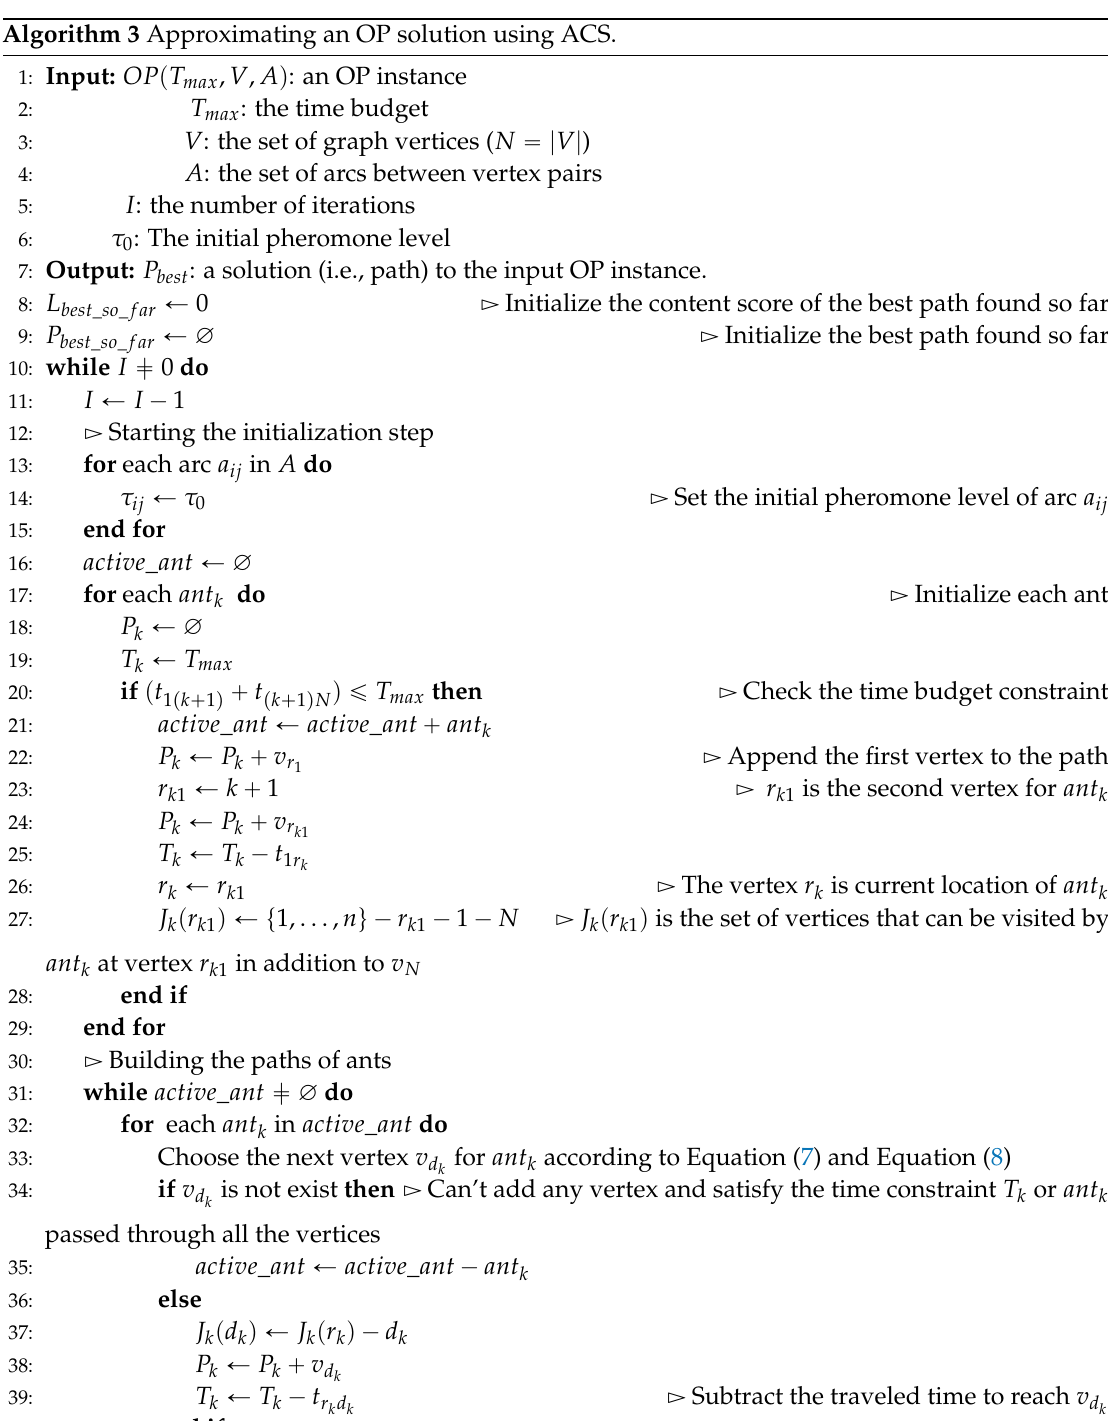
Algorithm 3 Approximating an OP solution using